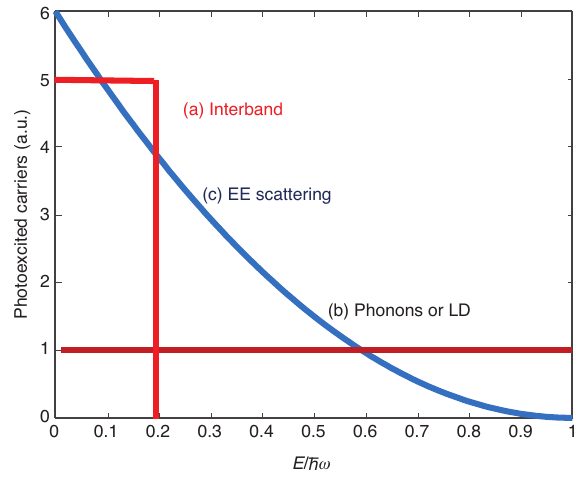
Figure 4: Energy distributions of carriers excited via different SPP decay mechanisms: (A) interband transitions; (B) phonon/defect- assisted transitions or Landau damping; (C) EE scattering-assisted transitions. Note that the area under curve (C) is twice as large as for the other two curves because two electron-hole pairs are generated for each decayed